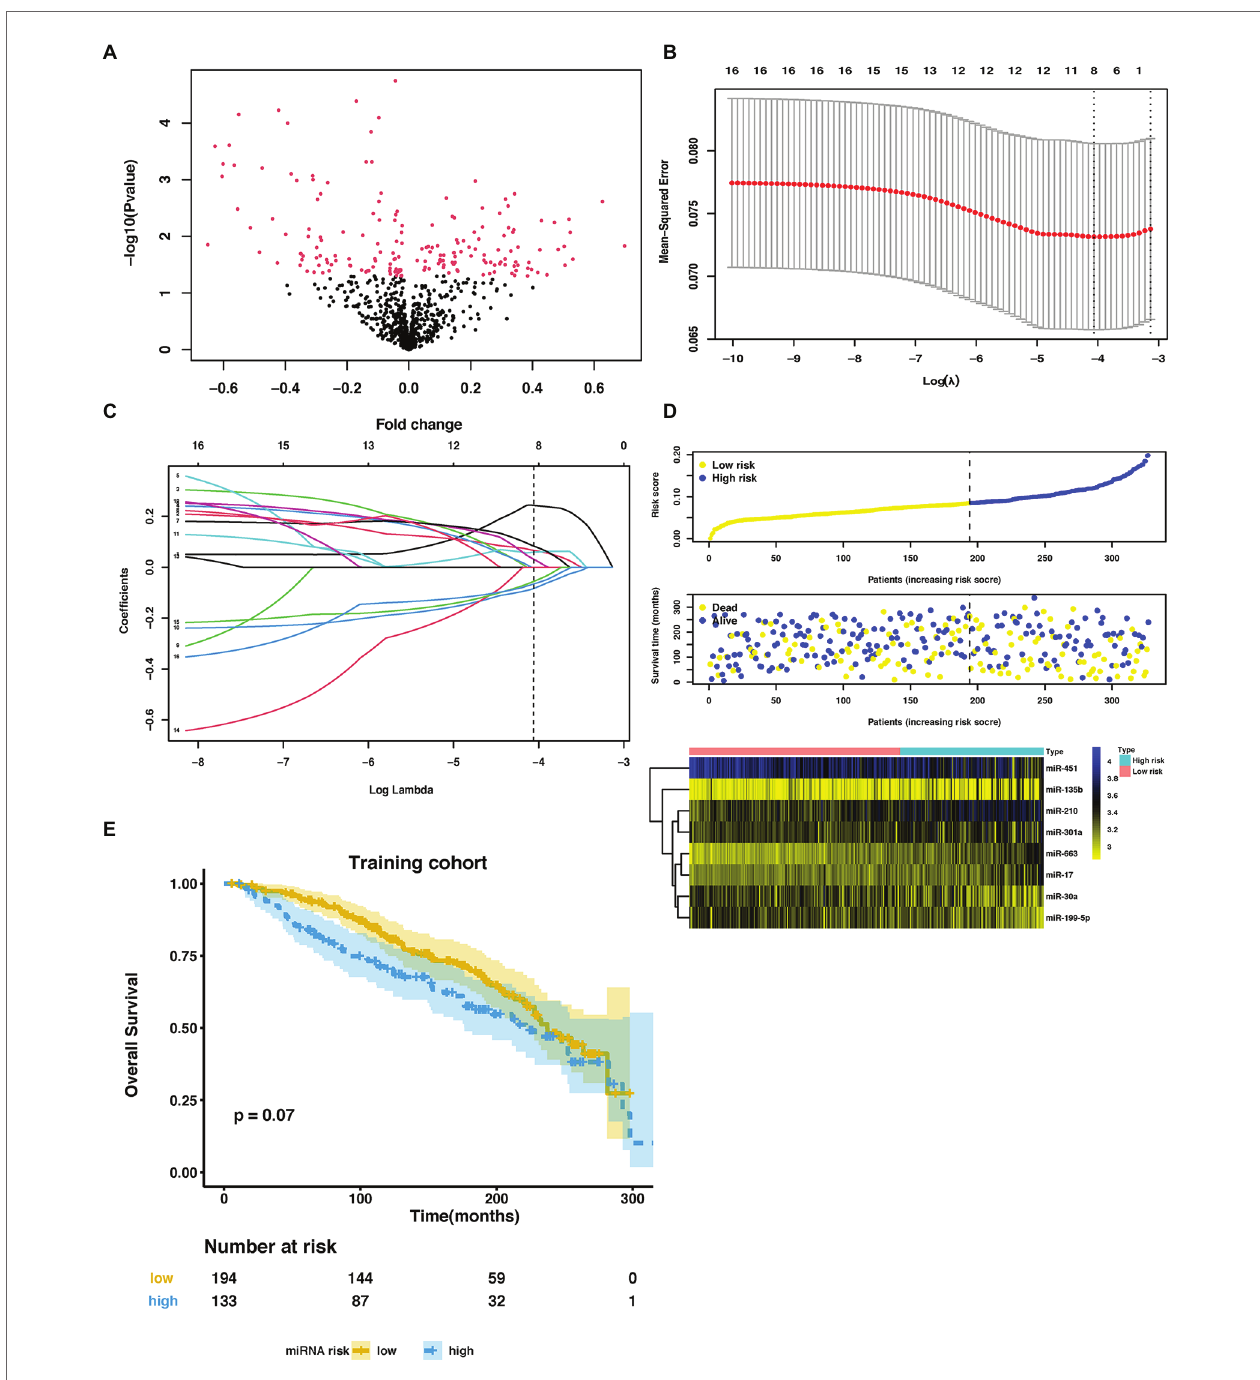
FIGURE 2 | Parameter selection to develop an eight-miRNA signature to distinguish lung metastasis status of breast cancer. (A) Volcano plot of miRNAs expression in the METABRIC dataset. (B) 3-fold cross-validation for parameter selection via minimum criteria in the LASSO model. Two dotted vertical lines were drawn at the optimal values by using the minimum criteria (the value of lambda that gives a minimum mean cross-validated error) and the one SE of the minimum criteria (the value of lambda that gives one SE away from the minimum error). (C) LASSO coefficient profiles of the 16 LM-related differentially expressed miRNAs (DEmiRNAs) in the training cohort. Each curve corresponds to a miRNA. The coefficient profile plot was against the log (lambda) sequence. The dotted vertical line was drawn at the value lambda = 0.01718646 selected by using 3-fold cross-validation via minimum criteria, where optimal lambda resulted in eight nonzero coefficients. (D) The distribution of risk score, overall survival (OS), vital status, and the expression profiles of eight-miRNA in the training cohort. (E) Kaplan-Meier (KM) curves of OS of breast cancer patients stratified by eight-miRNA risk score in the training cohort. METABRIC, molecular taxonomy of breast cancer international consortium; LASSO, the least absolute shrinkage and selector operation; miRNA, microRNA; LM, lung metastasis; and DEmiRNAs, differentially expressed